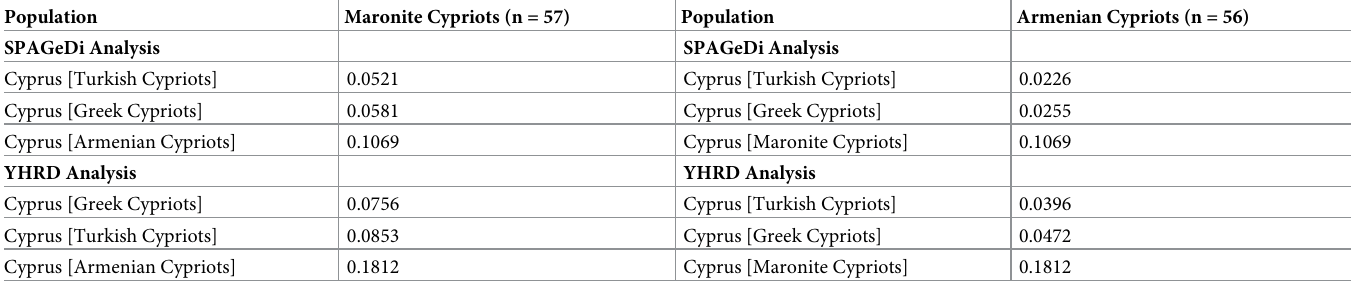
Table 2. Pairwise genetic distances (Rst values) between all